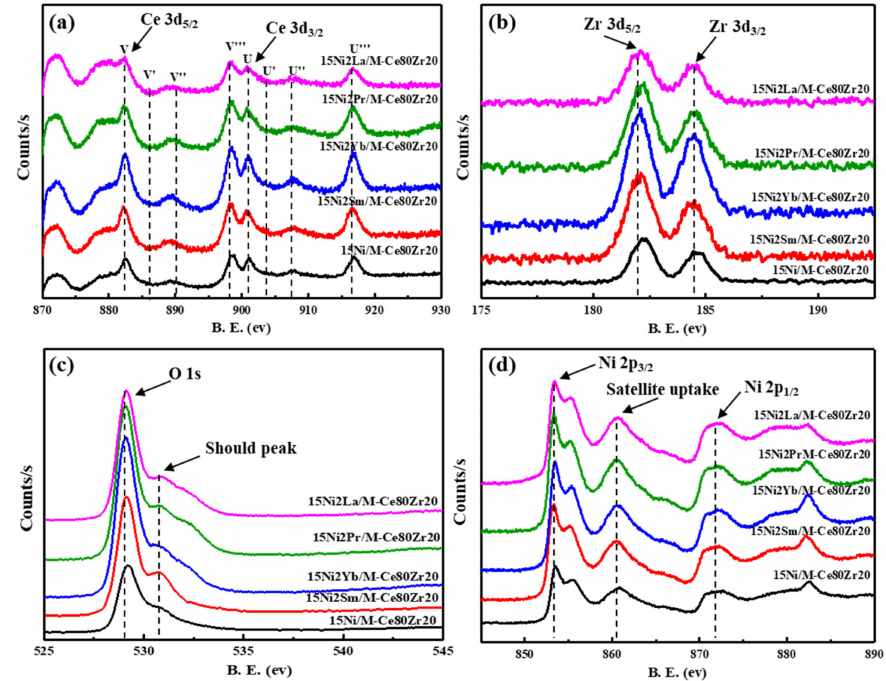
Figure 7. X-ray photoelectron spectroscopy (XPS) spectra of ( a ) Ce 3d, ( b ) Zr 3d, ( c ) O 1s, and ( d ) Ni 2p of the 15Ni2R/M-Ce80Zr20 (R = La, Sm, Pr, Yb)